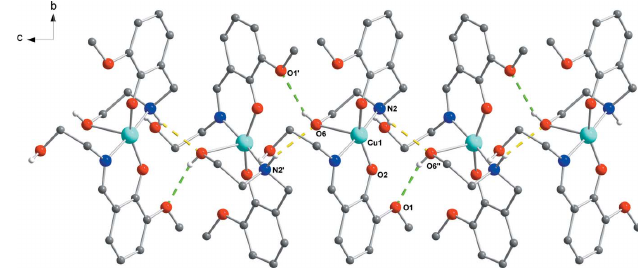
+ z ; ( 00 ) 1 (cid:5) x , 1 (cid:5) y , 2